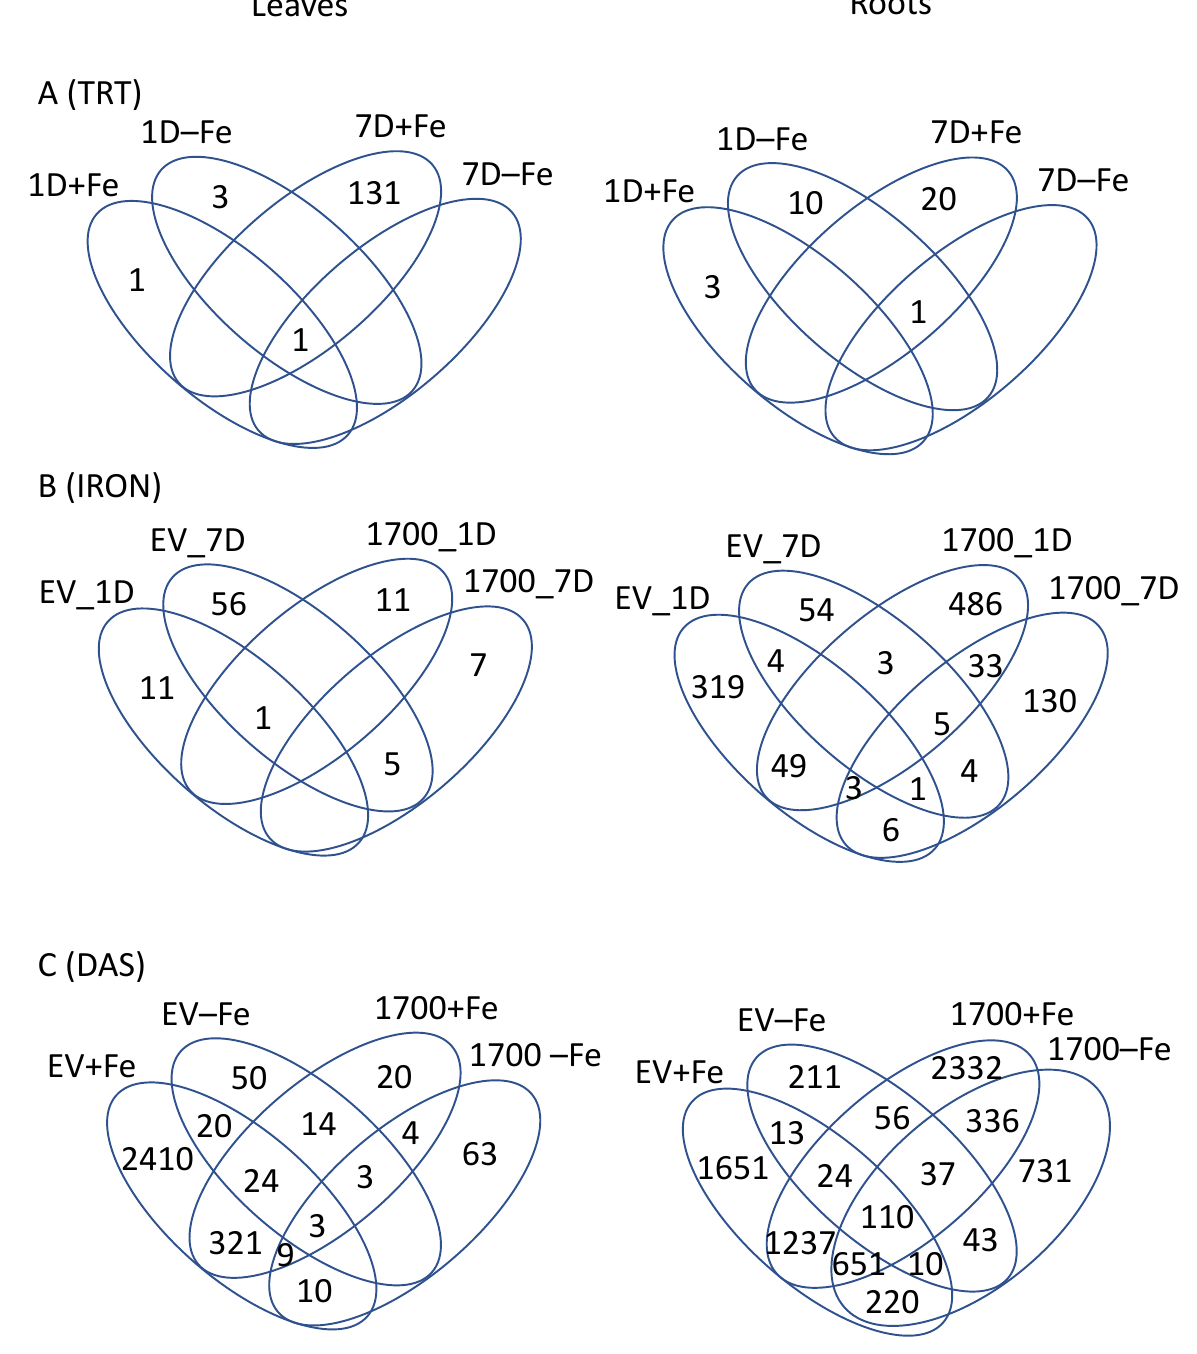
Figure 2. Distribution of differentially expressed genes. Venn diagrams detailing the distribution of statistically significant (FDR < 0.05) differentially expressed genes (DEGs) in each of the three analyses; treatment ( A , VIGS_Glyma.05G001700 vs. VIGS_EV), iron status ( B , Fe+ vs. Fe − ), and days after stress ( C , 7D vs. 1D) in leaves (left column) and roots (right column).